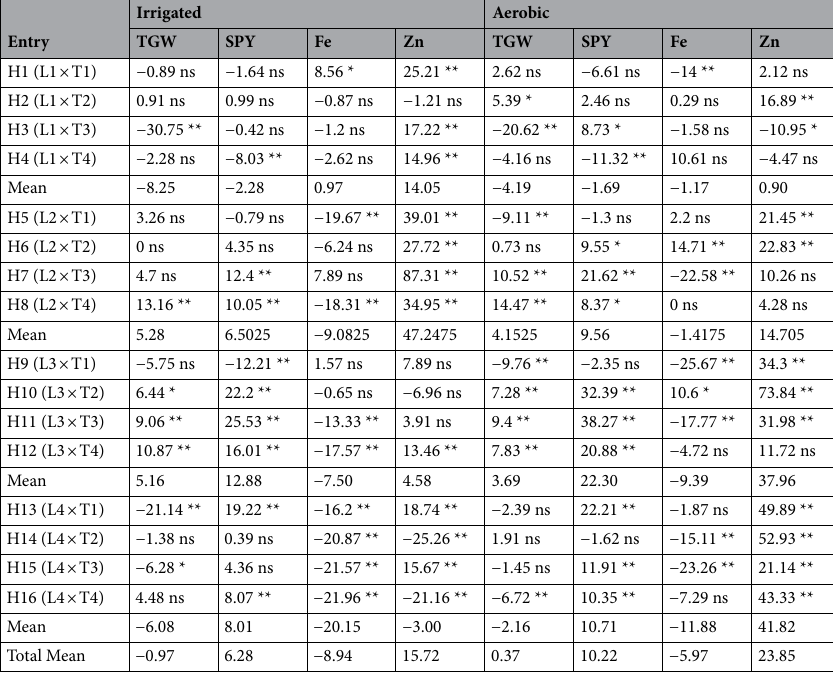
Table 5. Estimation of mid-parent heterosis (MPH) for yield components (TGW and SPY), grain Fe and Zn concentration of crosses (Hybrids) in irrigated and aerobic method. *P < 0.05; **P < 0.01; ns—not significant.